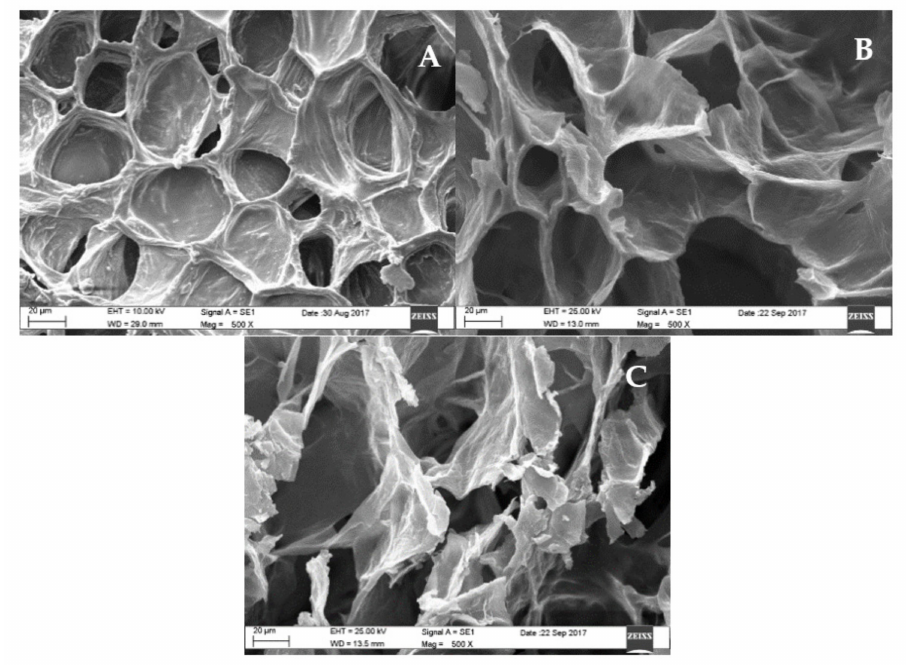
Figure 1. Micrographs of carrots cubes of 1 cm × 1 cm × 1cm: ( A ) raw; ( B ) processed at 110 ◦ C and ( C ) processed at 120 ◦ C. Data source: Hauck et al.